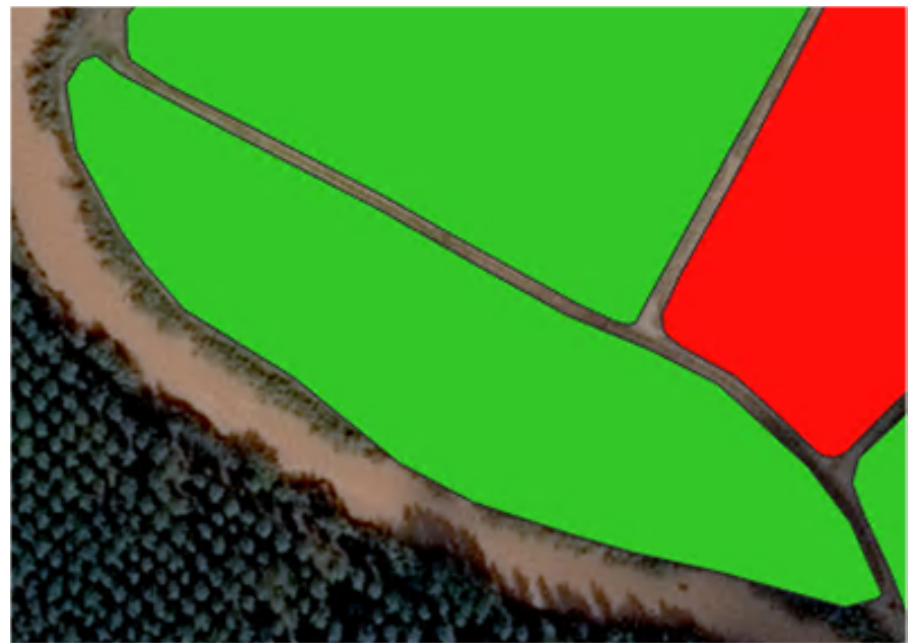
Figure 19. Method classification result based on biophysical indices.